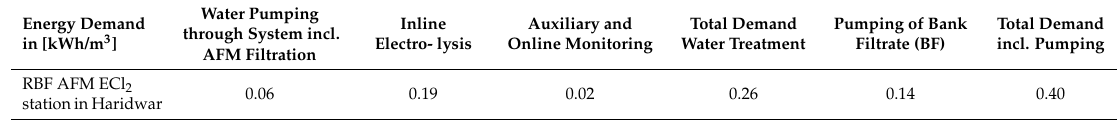
Table 5. Energy demand of the tested ECl 2